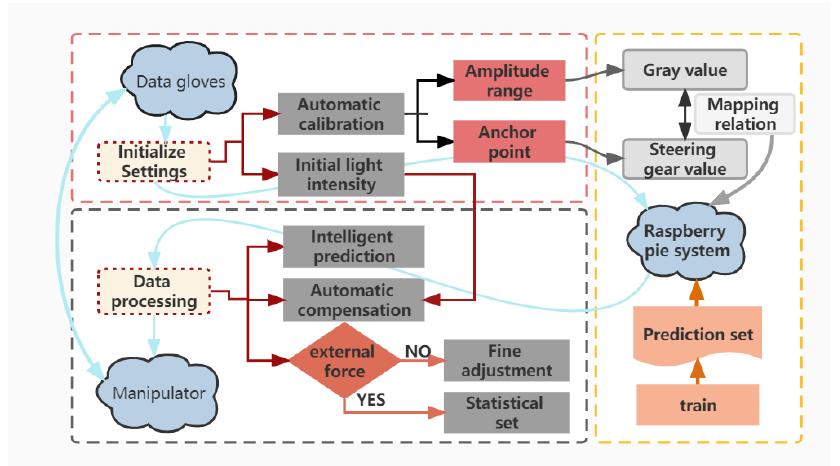
Figure 5. Flow chart of data collection and processing, including automatic calibration, intelligent prediction, automatic compensation and robust fine-tuning.